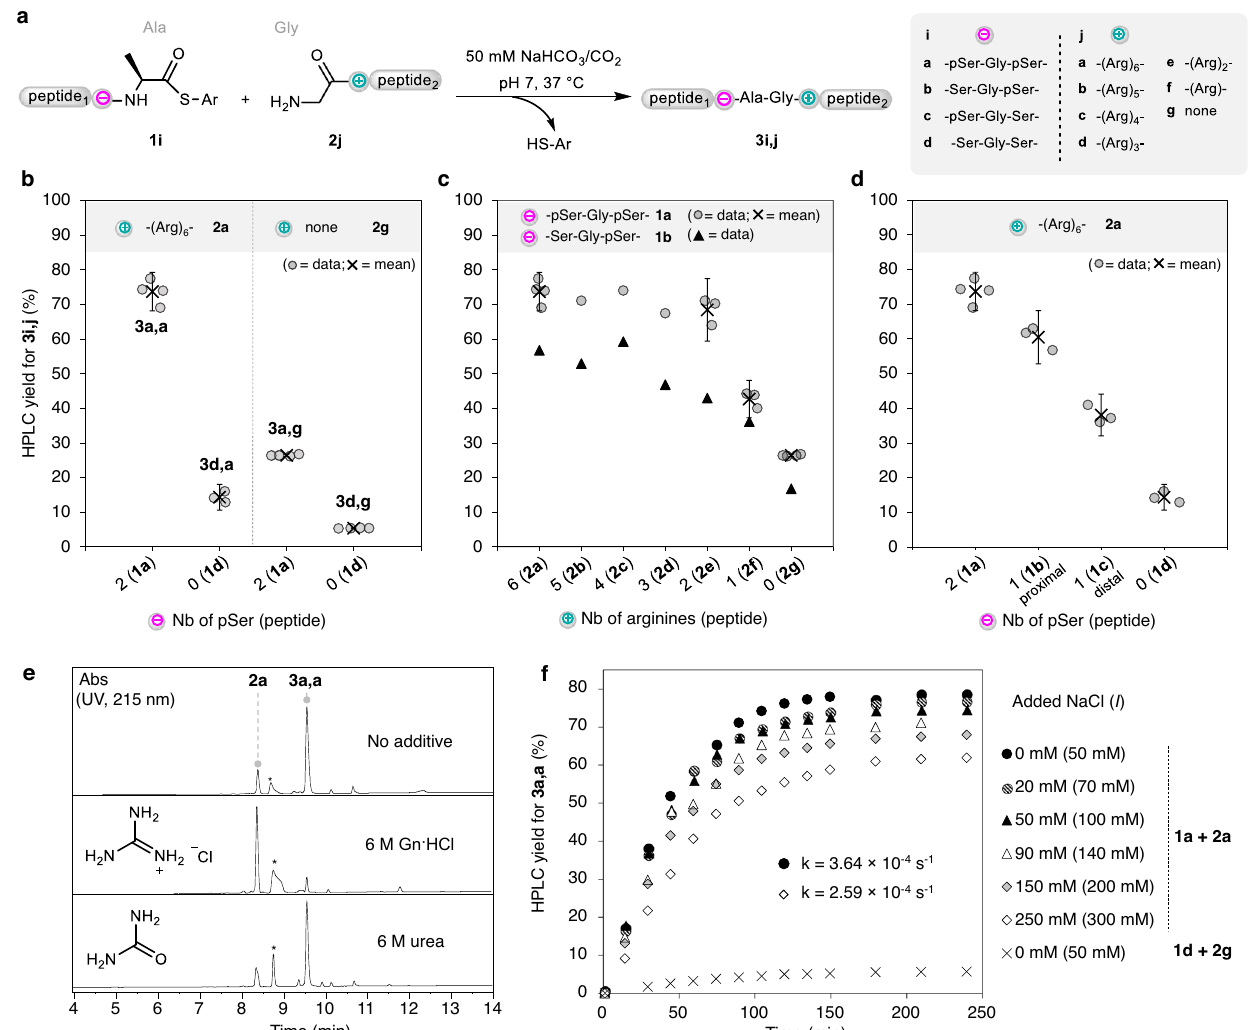
Fig. 3 | Effect of module type and additives on the electrostatic assistance of peptidethioesteraminolysis.a Reactionsstudied.Conditions:Peptidethioester 1 (5mM),glycylpeptide 2 (5mM), sodium hydrogencarbonate(50mM)/CO 2 buffer, 37°C, pH7. b – d When the error is indicated, the data correspond tothe meanand standard error for independent experiments (95% con fi dence